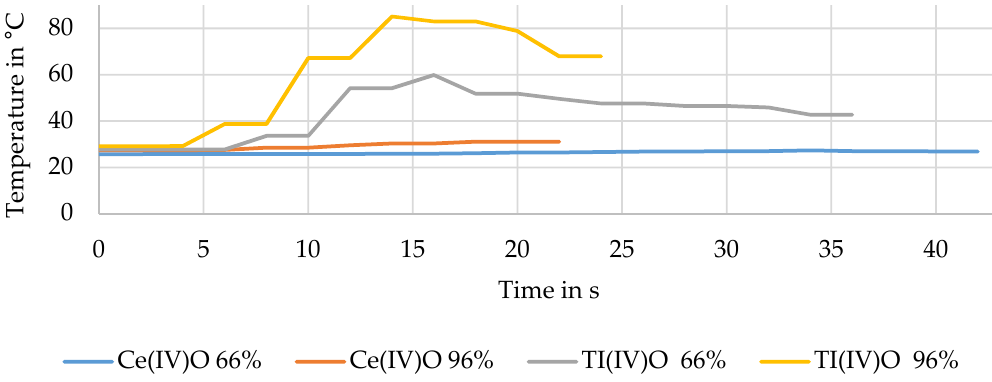
Figure 11. Temperature development underneath a UV radiator with and without the sample holder.